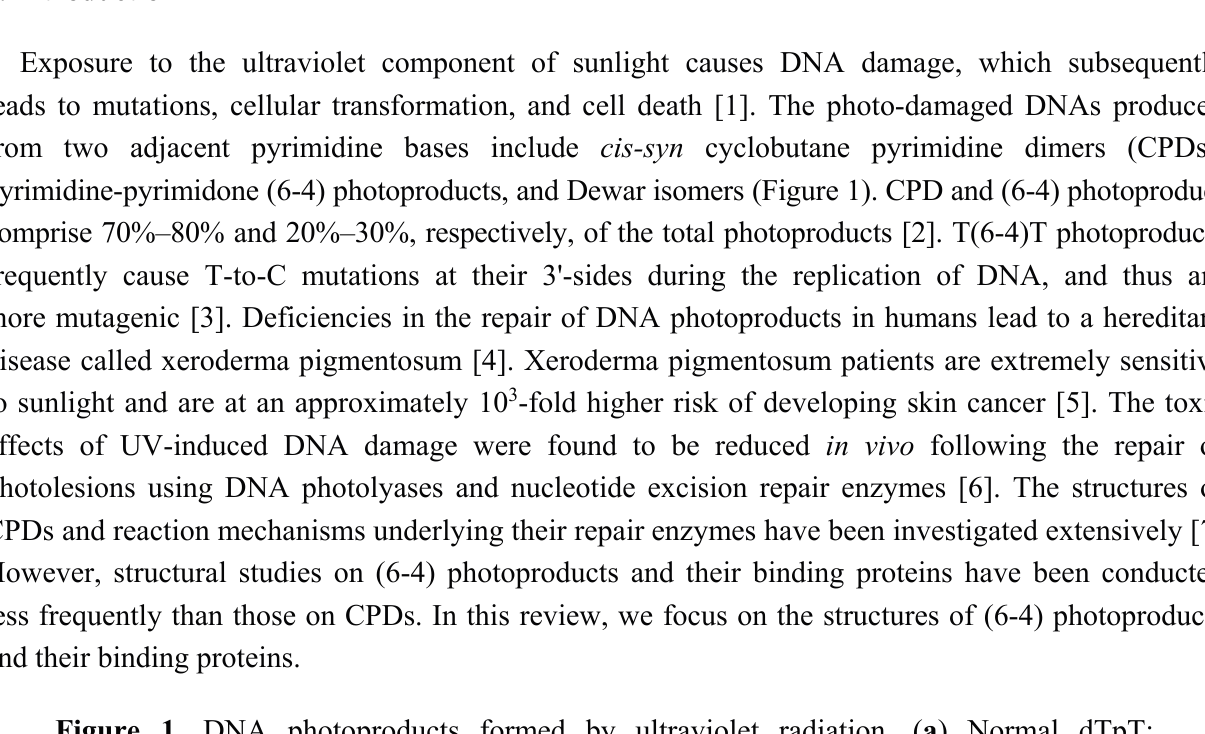
Figure 1. DNA photoproducts formed by ultraviolet radiation. ( a ) Normal dTpT; ( b ) cis-syn cyclobutane pyrimidine dimer (CPD); ( c ) Oxetane intermediate; ( d ) A dT(6-4)T photoproduct with atom numbering; and ( e ) Dewar